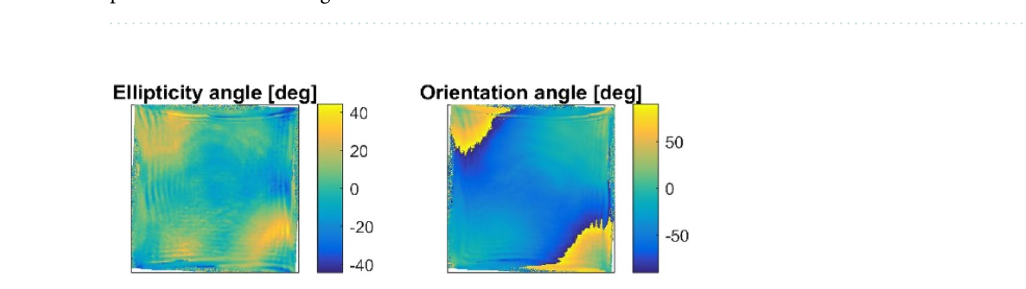
Figure 5. The parameters (ellipticity angle and the inclination angle of the principle axes of the polarization ellipse) of fully pre-compensated laser beam which would produce an unperturbed uniform vertical linear polarization after the propagation through the thermally loaded laser system characterized by the Mueller matrix M (Fig.